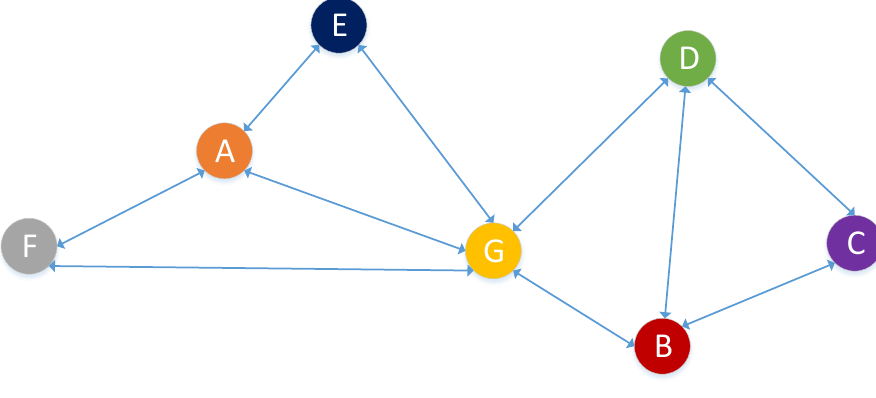
Figure 2. Graph structure representation between different road